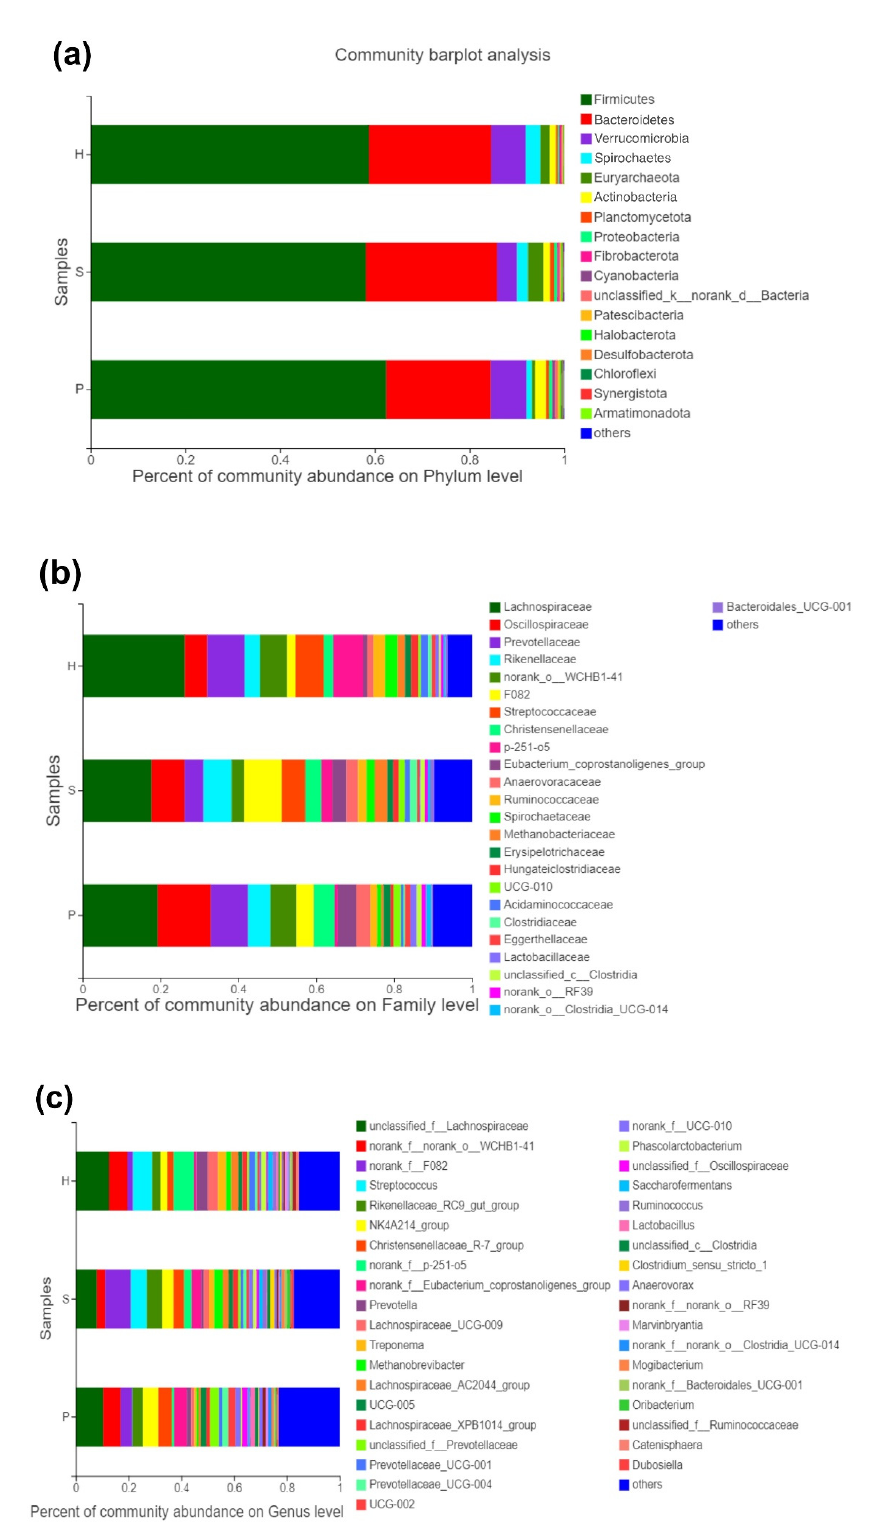
Figure 2. Relative abundance of the dominant bacterial community at the phylum ( a ), family ( b ), and genus ( c ) levels of the three groups. The Student’s t -test was used to assess the difference between the alpha diversity of the groups of